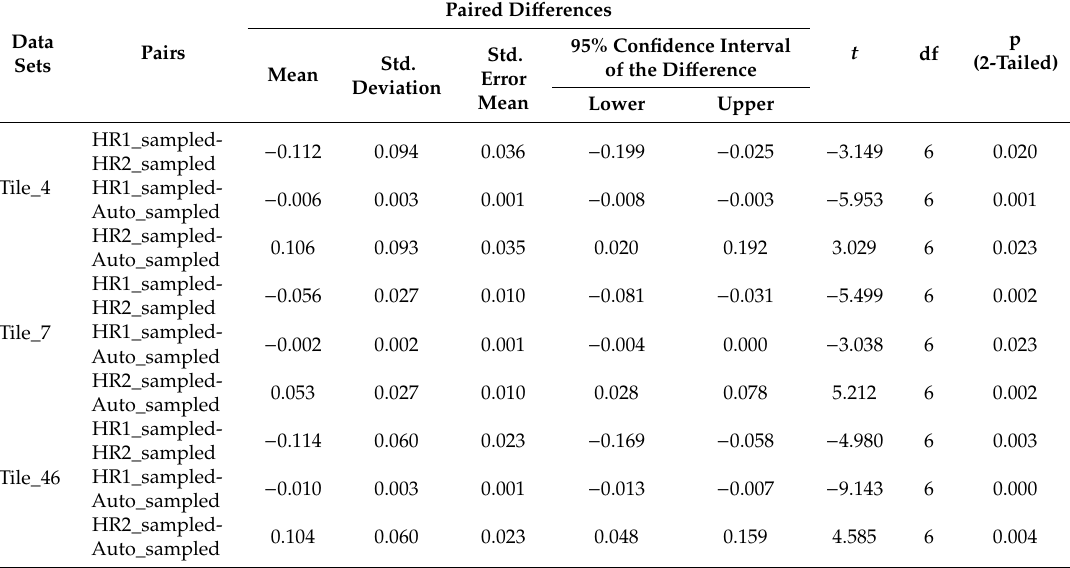
Table 5. Results of paired t -test for comparing the DRP concentrations obtained by the hybrid resin-sampling method and the auto-sampling method. The passive-sampling data were calculated based on the laboratory calibration data. DPR concentrations of each auto-sampled tile water were compared with the calculated DPR concentration in corresponding passive-sampling periods. The data are shown in Figure